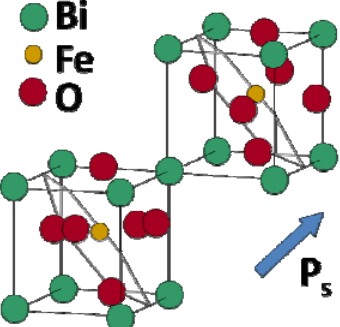
Figure 6. Schematic of the crystal structure of BFO, showing the direction of spontaneous ) as well as the antiferromagnetic ordering (displayed in the grey plane), polarization (P s reproduced from Chu et al.